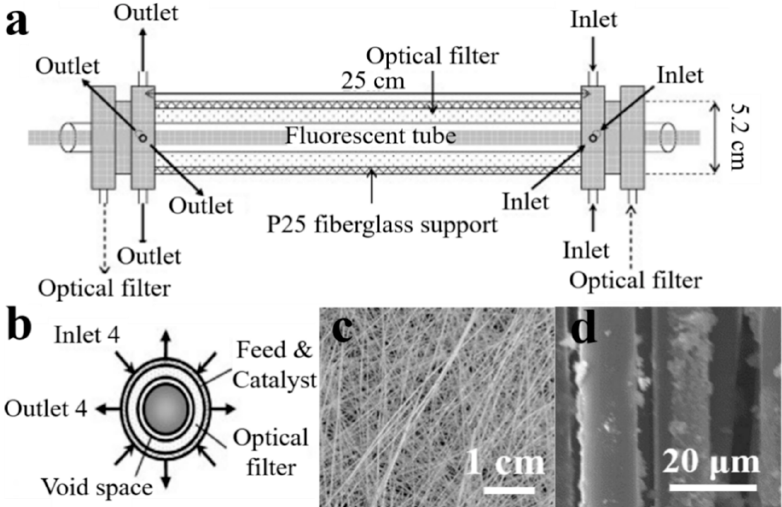
Figure 4. Schematic representation of annular photocatalytic reactor ( a , b ) [90]. Copyright 2008, Elsevier. Optical picture of catalyst coated fiber glass support ( c ) and SEM picture of individual catalyst coated fiber ( d ) [91]. Copyright 2006, Elsevier.